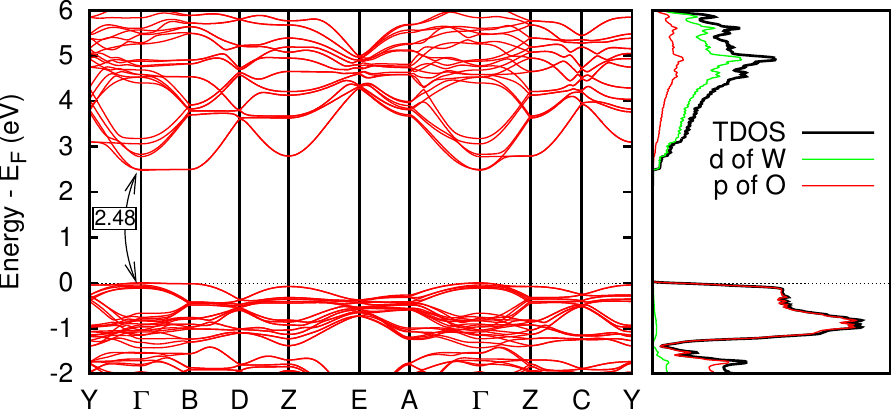
Figure 3. Band structure of γ -monoclinic WO 3 and density of